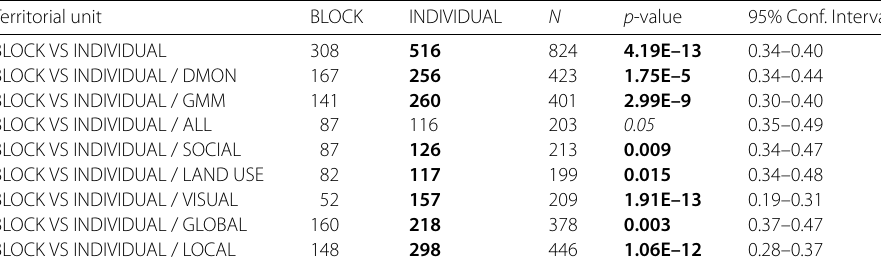
Table 5 Results obtained for territorial unit from the survey ∗